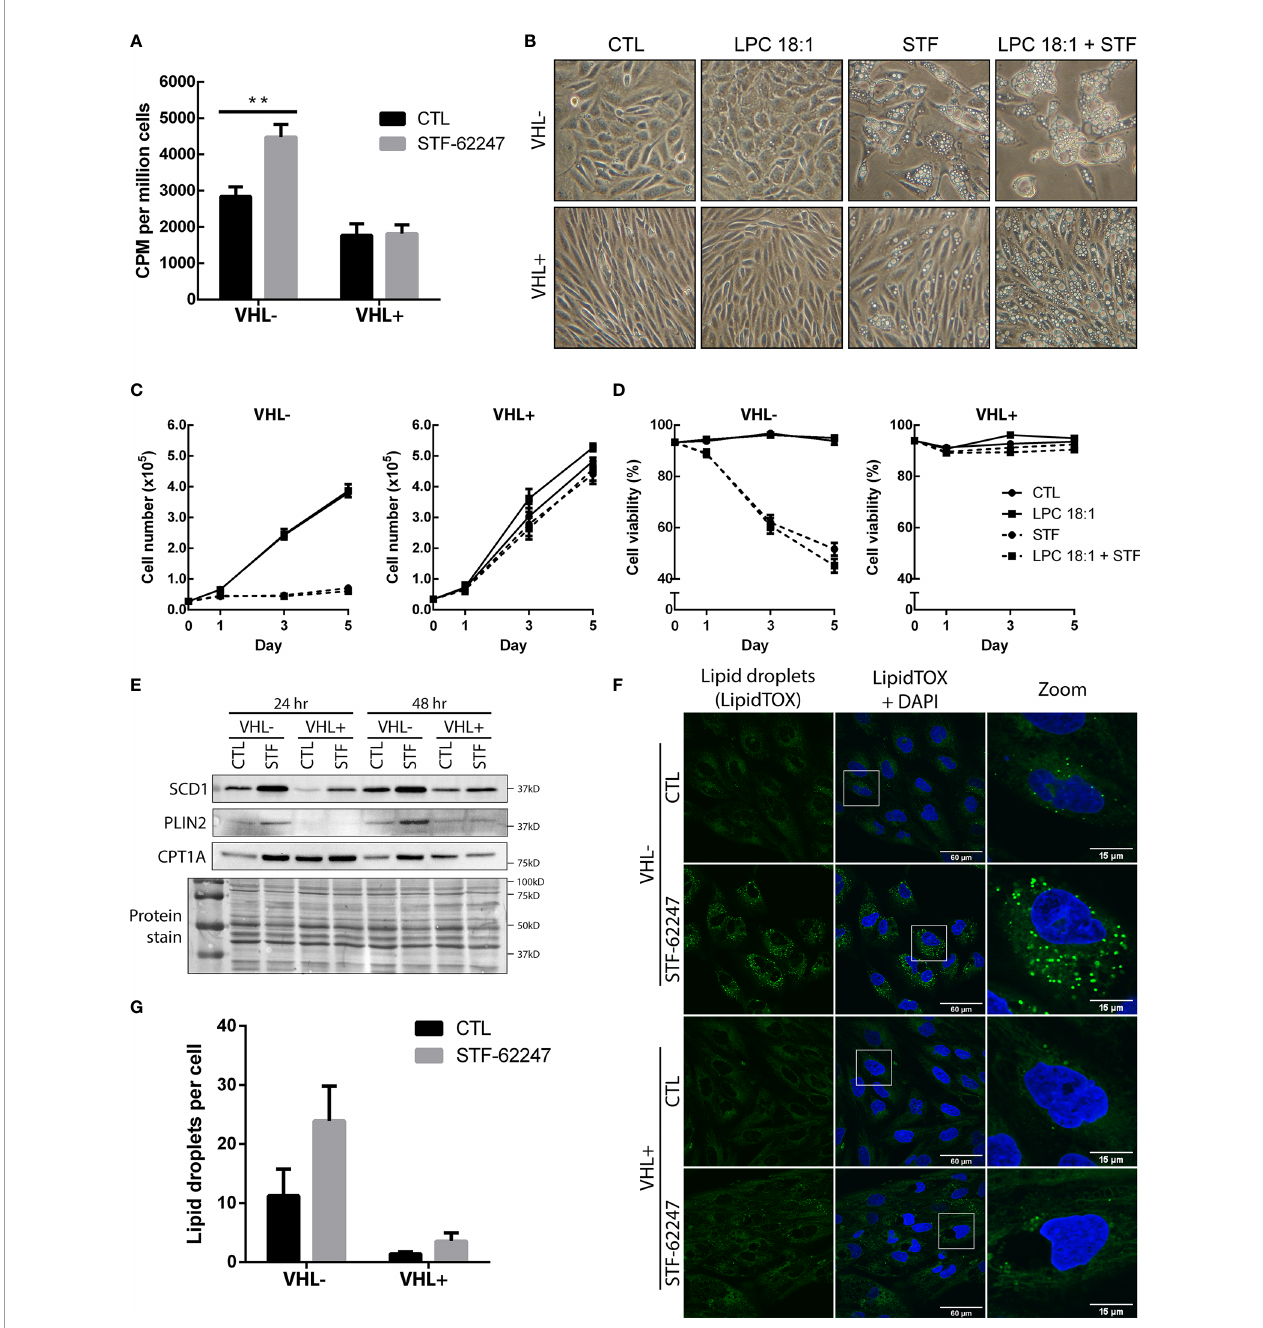
FIGURE 5 | Increase usage of glutamine to produce fatty acids result in the accumulation of lipid droplets in VHL de fi cient cells. (A) Incorporation of radiolabeled carbon (C14) from glutamine into fatty acids in RCC4 VHL- and VHL+ cells after 24 hr of STF-62247 treatment. Culture media was changed for the last hour of treatment with media containing 0,2 m Ci/mL (L-[14C(U)]-Glutamine. Radioactivity (counts per minute (CPM)) was measured in lipid extracts from RCC4 VHL- and VHL+ and normalized with the number of cells (N=4). (B) Inverted-light microscopy images of vacuolization in RCC4 VHL- and VHL+ cells treated with 1.25 µM STF- 62247 and/or 25 µM LPC 18:1 after 3 days. (C) Proliferation (D) and viability of RCC4 VHL- and VHL+ cells treated with 1.25 µM STF-62247 and/or 25 µM LPC 18:1. Cells were counted on days 0, 1, 3 and 5 with trypan blue to evaluate cells viability (N=3). Statistical marks shown in cell proliferation and viability curves are either between CTL and LPC 18:1, or between STF and STF + LPC 18:1 condition. (E) Immunoblot analysis of proteins implicated in fatty acids and lipid droplets metabolism. Cells were treated for 24 hr and 48 hr with 1.25 µM STF-62247. (F) Immuno fl uorescence of fi xed RCC4 VHL- and VHL+ cells stained with LipidTOX (green) and DAPI (blue) after being treated for 48 hr with 1.25 µM STF-62247 (N=3). (G) Lipid droplets (LipidTOX) puncta (F) were analyzed and counted with Fiji (ImageJ). Results are presented as means and SEM of at least three independent experiments. Statistical analyses (Two-Way ANOVA followed by Tukey ’ s test) were performed to assess signi fi cant differences in the results (A, C, D, G) . (**p <